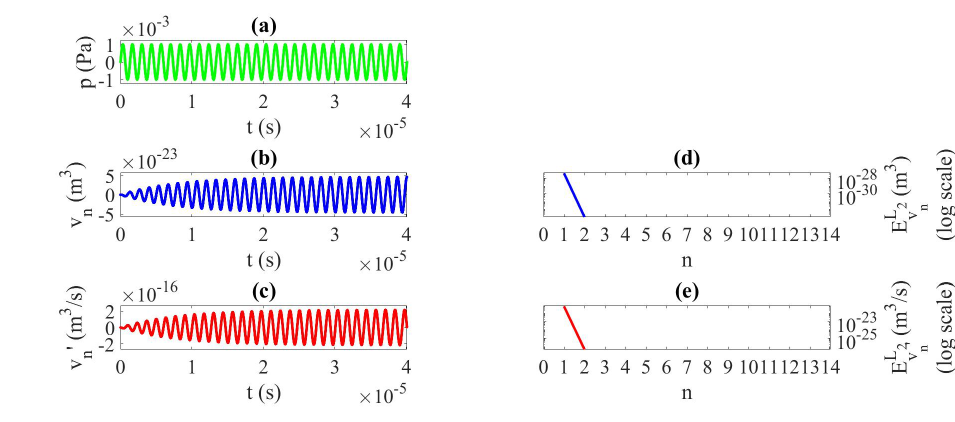
Figure 4. Case 1 (cid:48) . f = f b , infinitesimal amplitude with nonlinear terms. ( a ) Pressure source signal, ( b ) bubble-volume variation, ( c ) speed of bubble-volume variation; last iteration n = N . L 2 -norm error at each iteration n of the calculation; ( d ) v n , ( e ) v (cid:48) n